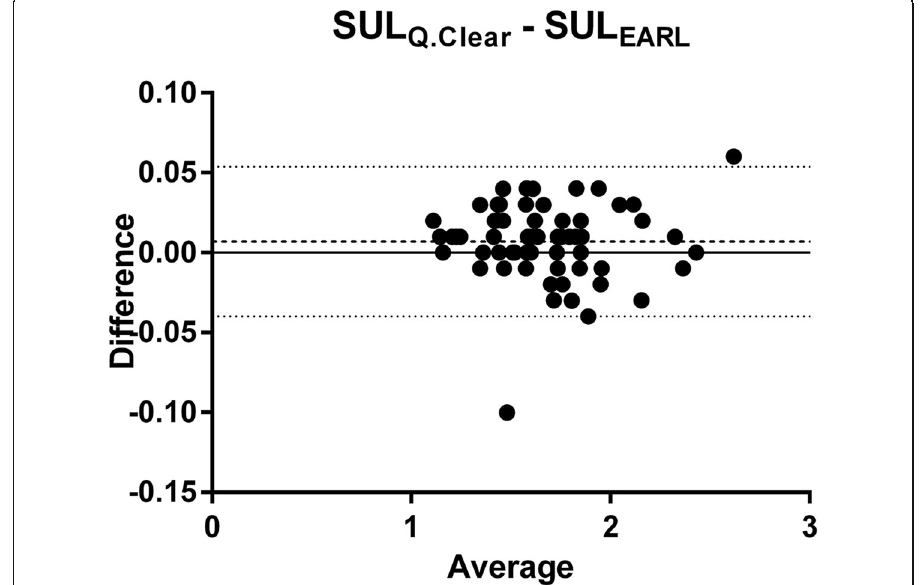
Fig. 2 Bland-Altman plot of liver SUL mean comparison between two reconstruction protocols (dashed line: mean difference, dotted lines: